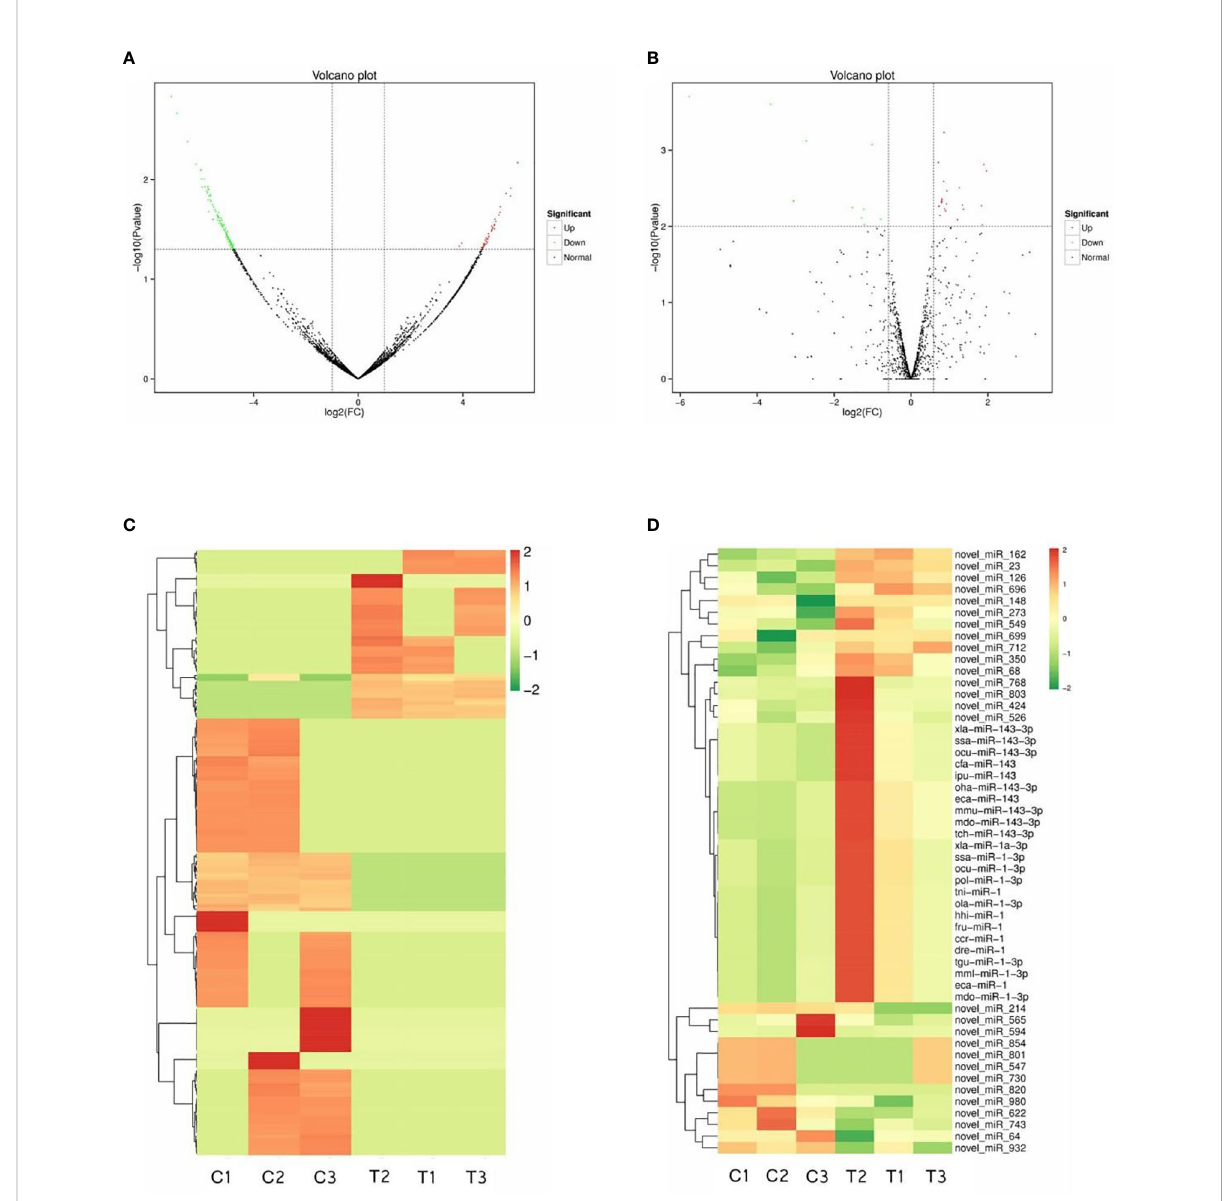
FIGURE 2 Differentially expressed circRNAs and miRNAs. Volcano plot fi gures of identi fi ed circRNAs (A) and miRNAs (B) . Heatmaps of differentially expressed circRNAs (C) and miRNAs (D)